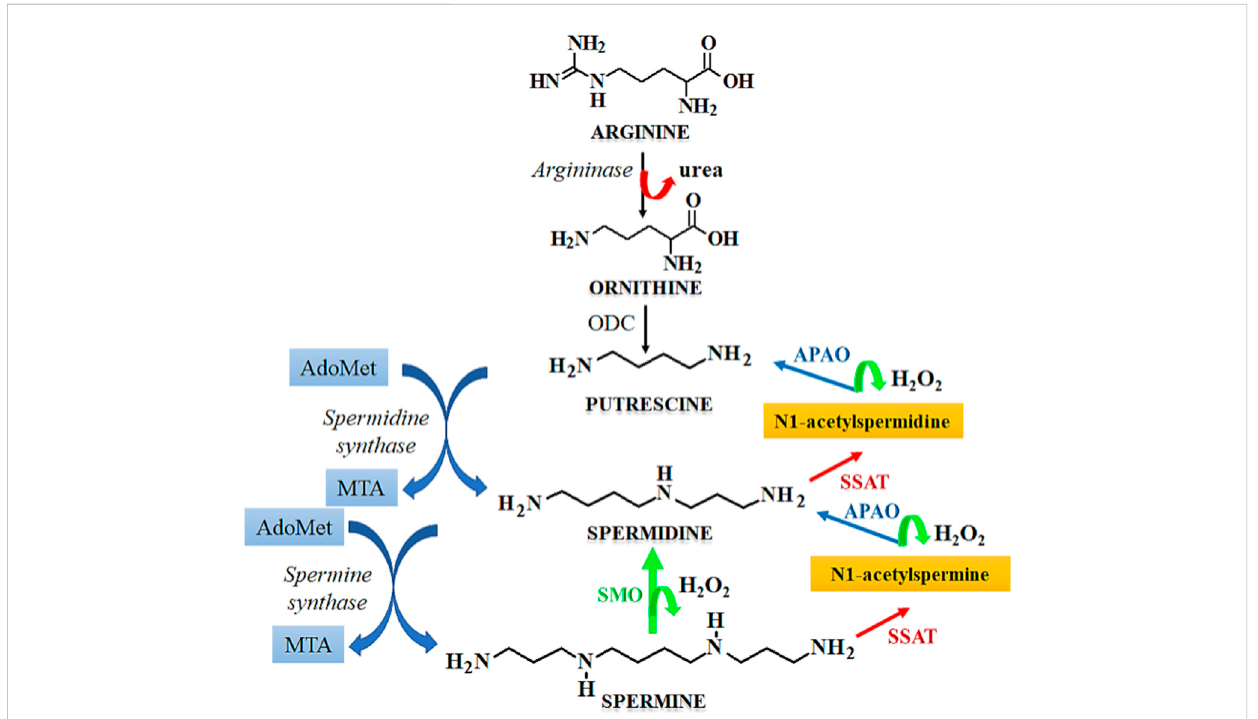
FIGURE 7 Mechanism of polyamine metabolism and the role of SSAT. Abbreviations: AdoMet, S-Adenosylmethionine; MTA, Metastasis associated protein; APAO, N1 acetylpolyamine oxidase; SSAT, Spermidine/spermine N1-acetyltransferase; ODC, Ornithine decarboxylase; SMO, smoothened receptor.